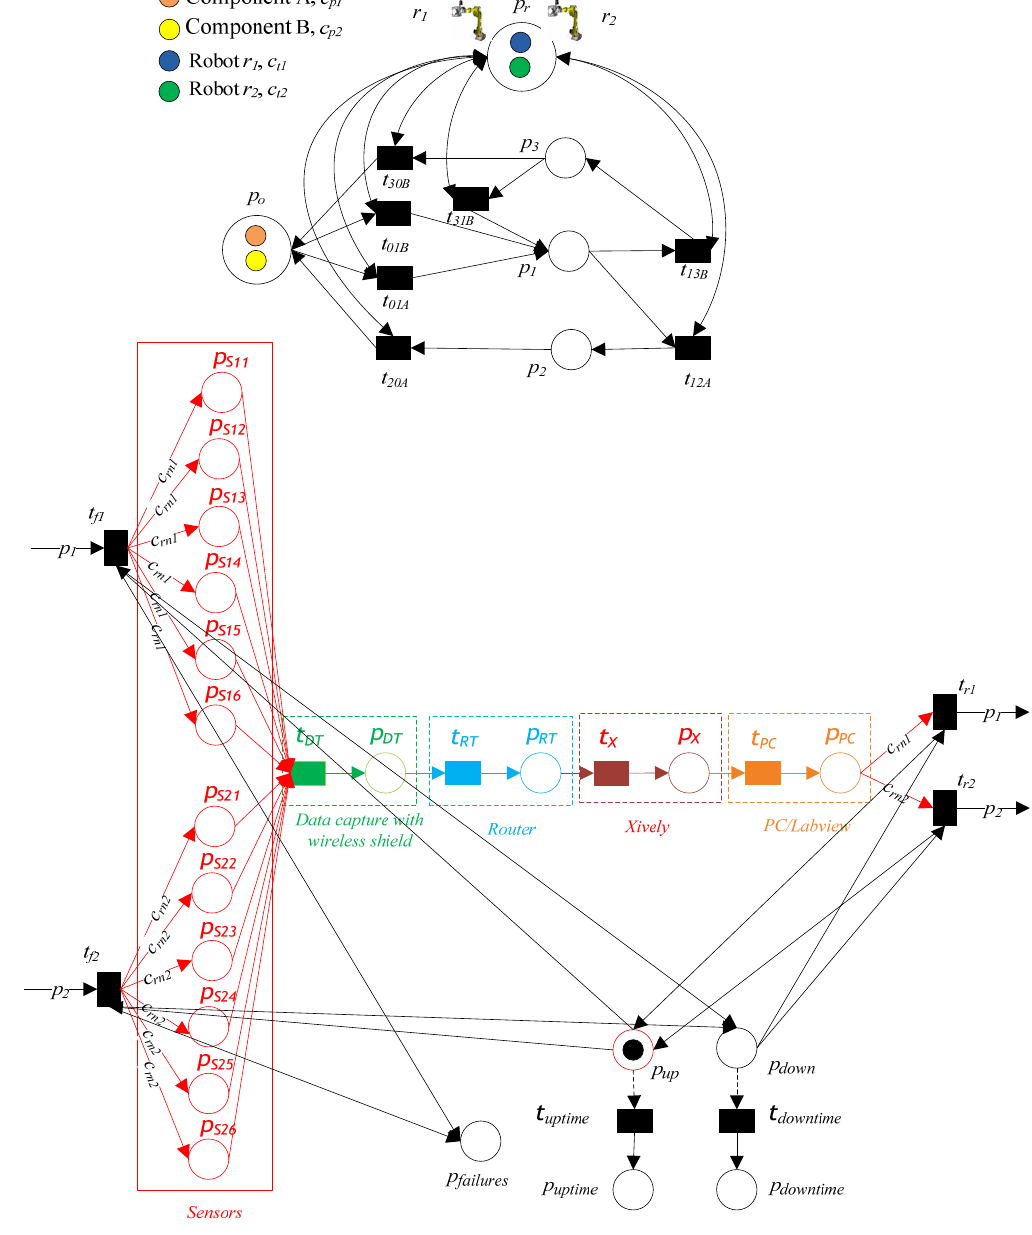
Figure 11. The unreliable CROPN based on IoT and reliability model for the model shown in Figure